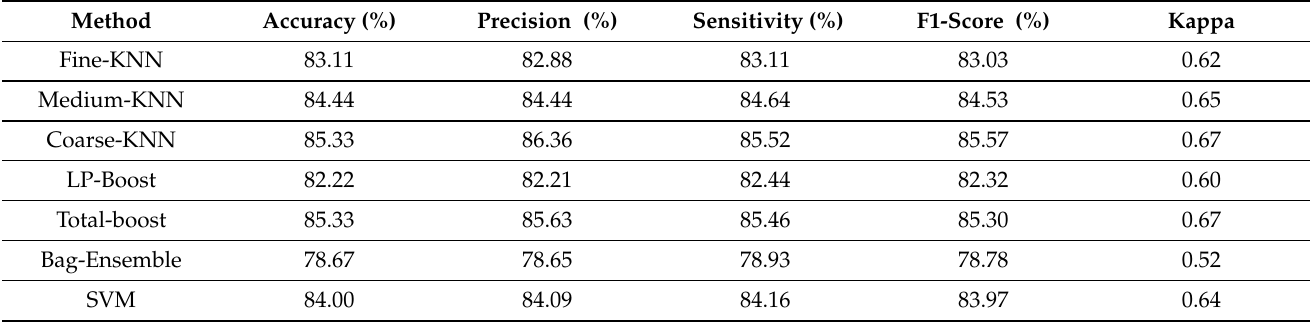
Table 5. Results obtained using different ML classifiers on 50–50 Split.